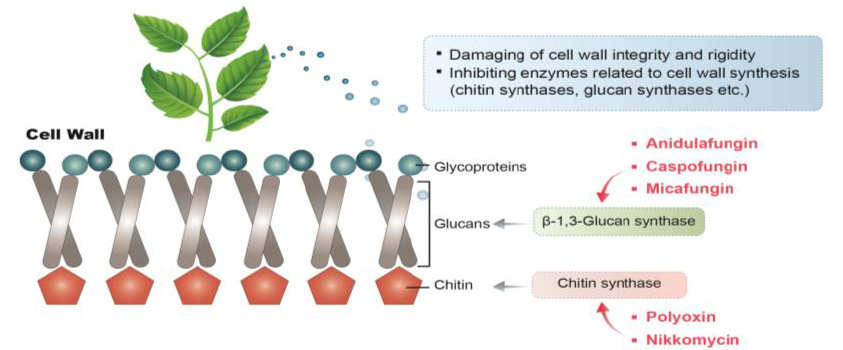
Figure 2. Mechanisms of action of plant-derived natural compounds and antifungal agents acting on the cell wall of A. flavus .